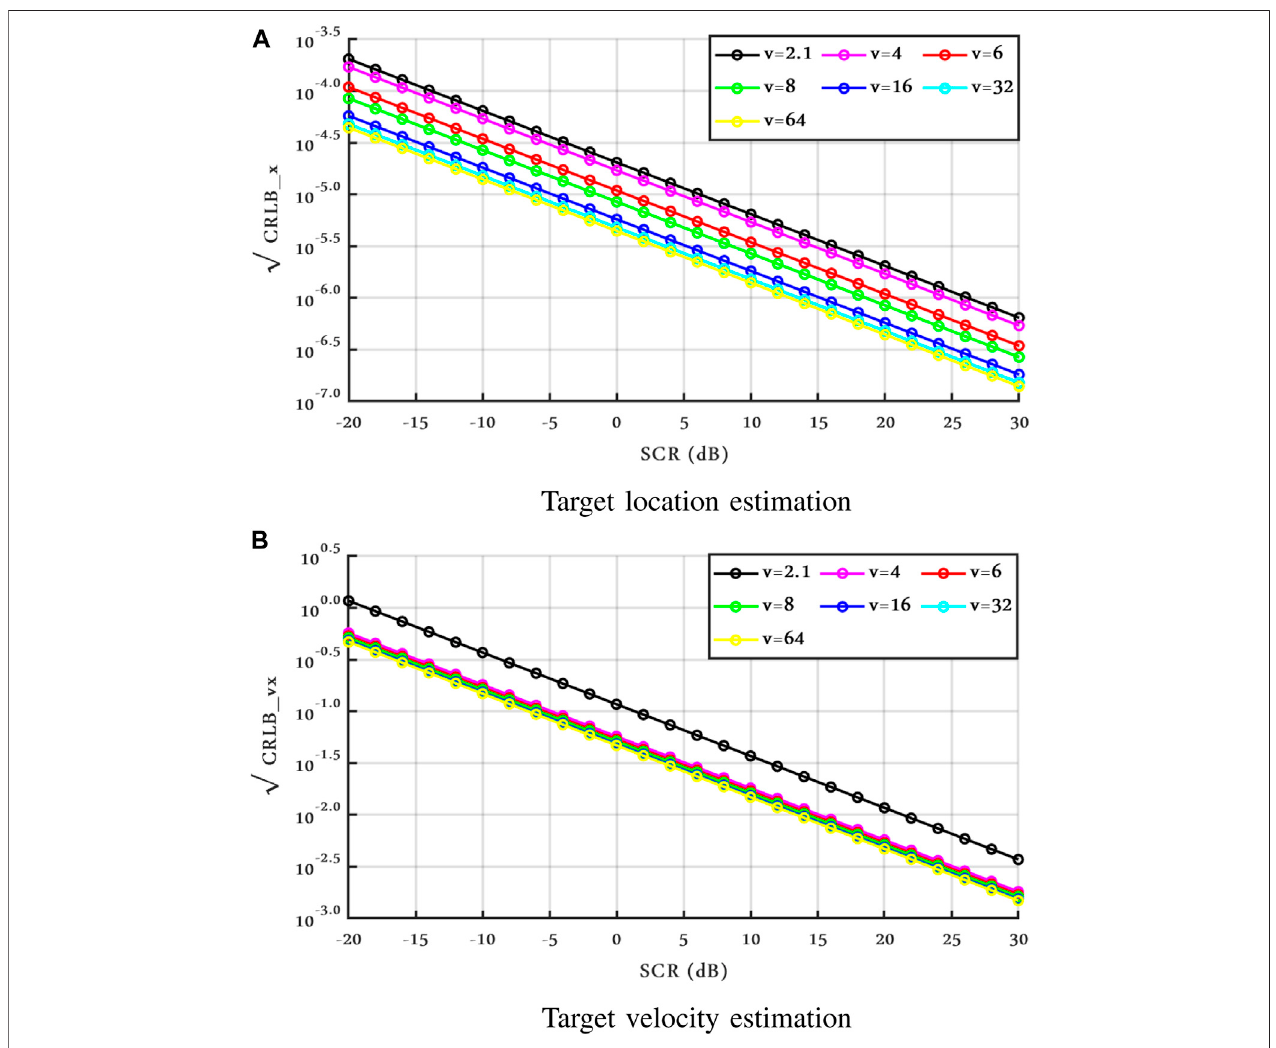
FIGURE 6 | CRLBs vs. SCR with different ] , Clutter Model II, ρ = 0.9.